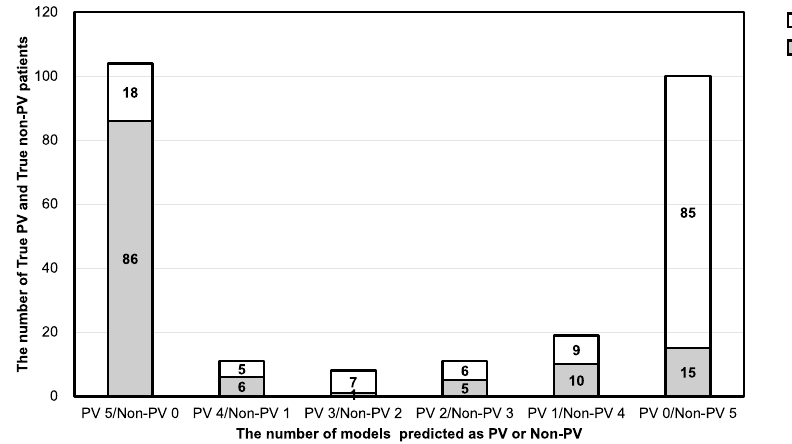
Figure 4. Evaluation of the accuracy of the five machine learning models in the testing dataset (n = 253). PV peripheral vestibular disease, Non-PV non-peripheral vestibular